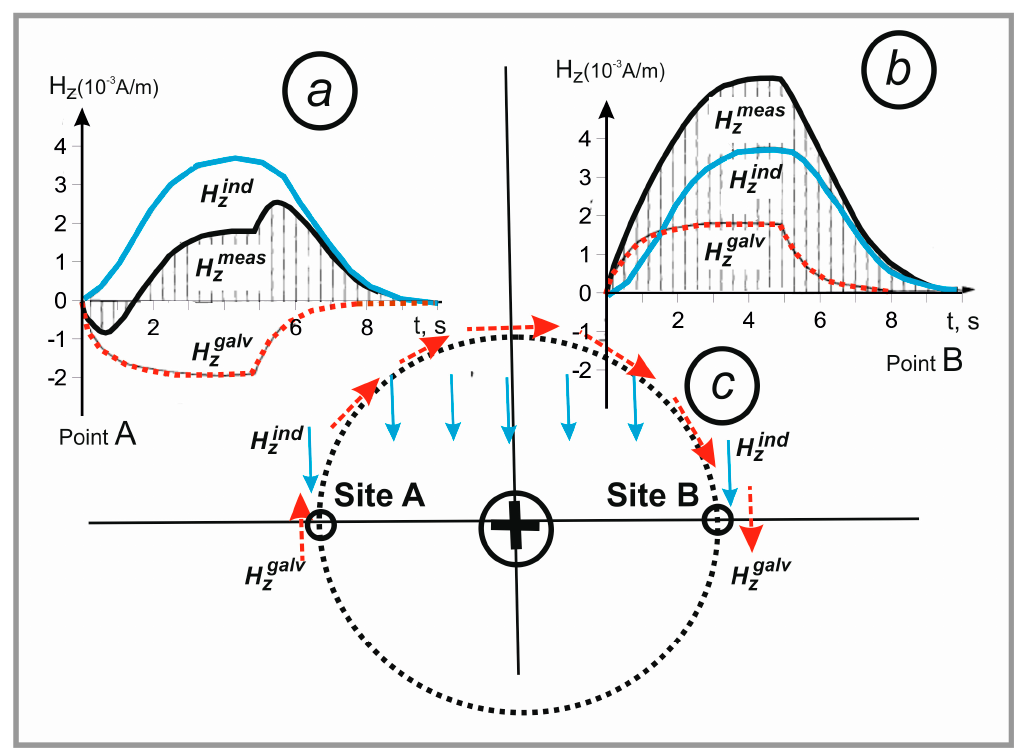
Figure 2. Scheme of magnetic fields, measured from MHD-installation “Khibiny” in opposite sides of the current-conducting channel. ( a ) Curves of the vertical magnetic field for the left site “A”: H ind z (blue)—induced by sea currents, Hz galv (red, dashed)—based on galvanic currents in the ground and Hz meas = H ind z + Hz galv (black, solid) measured magnetic field; ( b ) same for right site “B”; ( c ) vectors of magnetic field: Hz galv from current “+”, flowing away from observer (dashed arrows) and H ind z from distant currents in the sea (solid arrows).